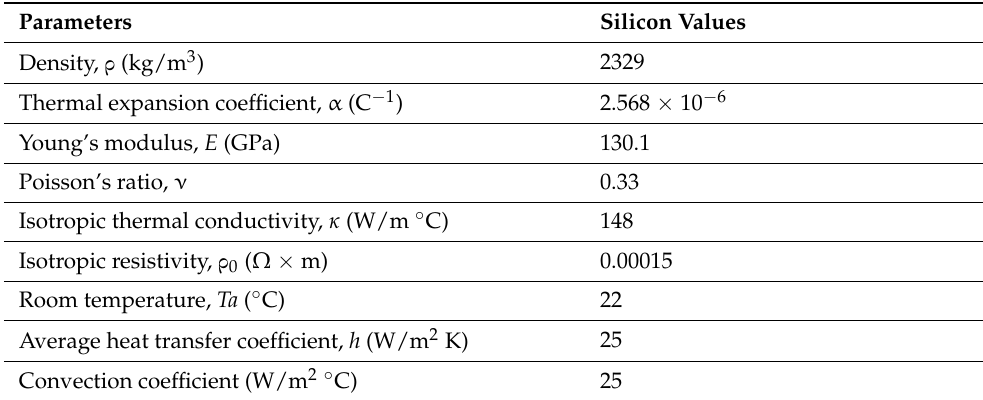
Table 3. Mechanical and electrical properties of materials